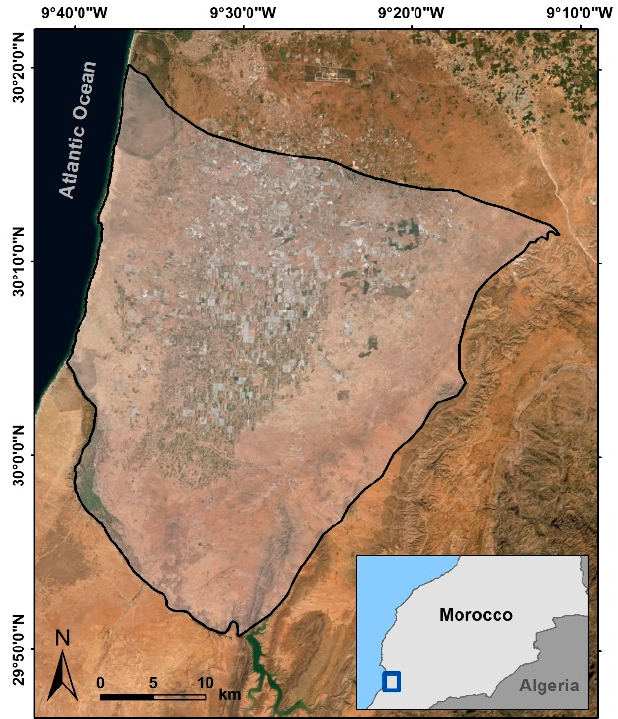
Figure 1. Study area: Chtouka aquifer in the south of Morocco.